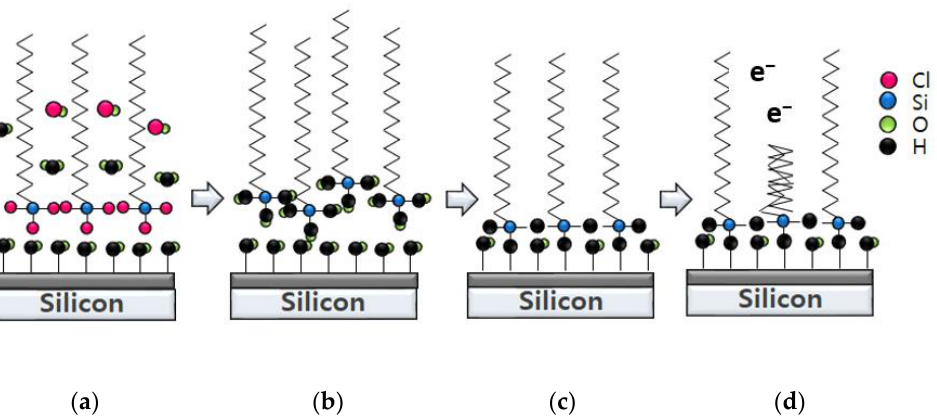
Figure 6. Mechanism of OTS patterning by C-beam: ( a ) OTS physisorption on Si substrate after coating; ( b ) HCl desorption by Si substrate surface and OTS reaction; ( c ) Si−H bonding and hydrophobic terminal formation; ( d ) bond breaking by electron beam and weakened hydrophbic property.